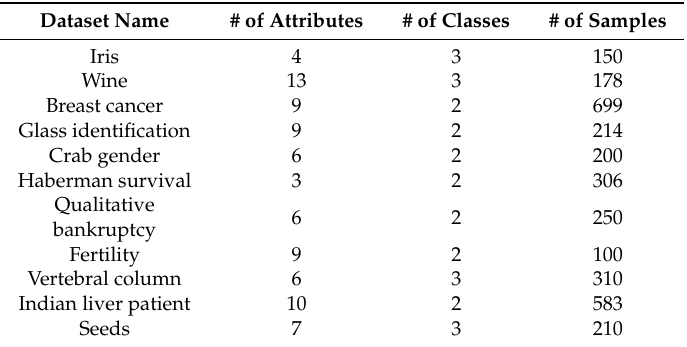
Table 1. Description of used classification benchmarks.